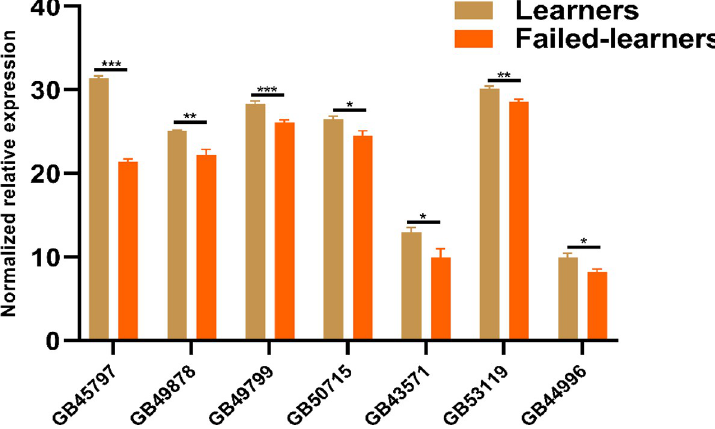
Fig 5. qPCR analysis of differentially expressed genes between learner and failed-learner bees. Independent t-test, � P < 0.05, �� P < 0.01.